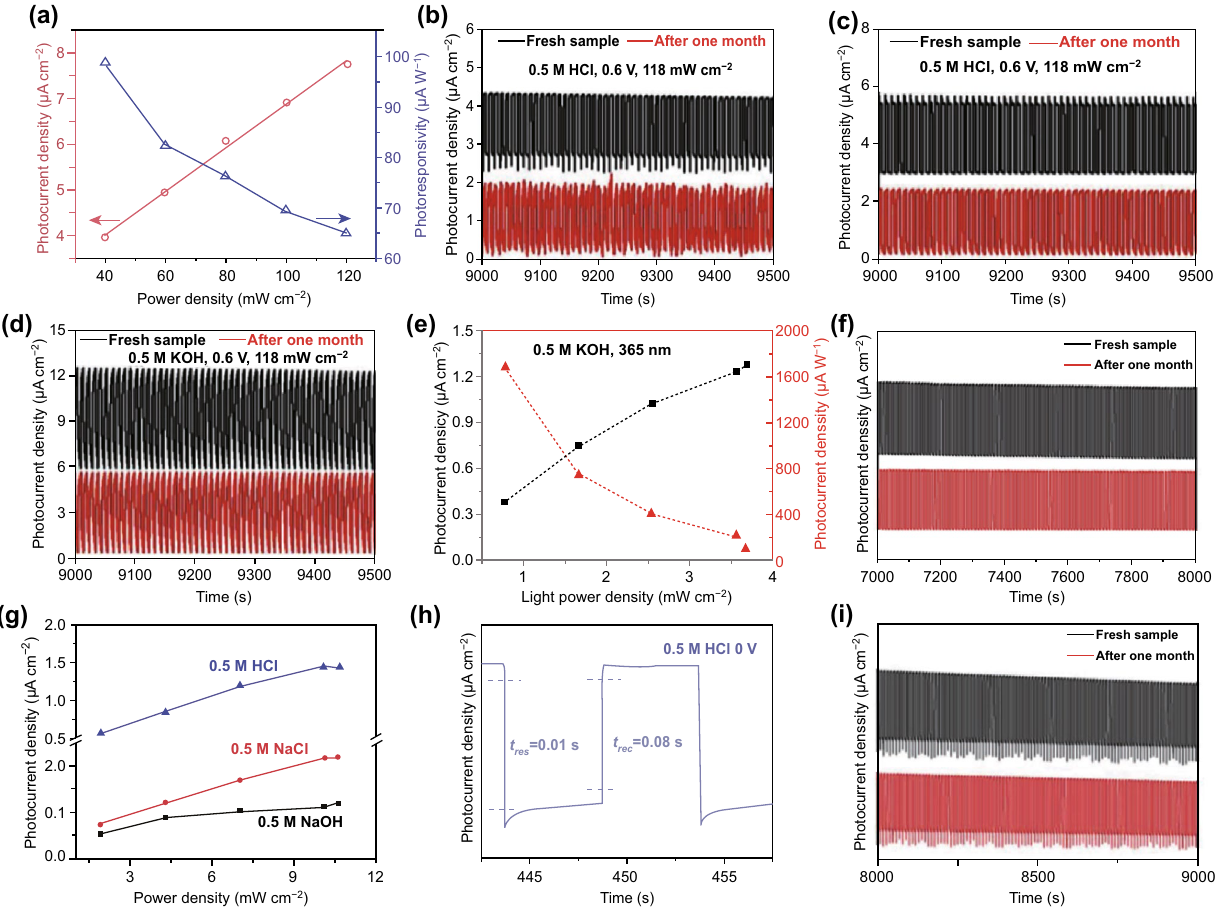
Fig. 11 a Photocurrent density and photoresponsivity of Te 0.37 @Se 0.63 as a function of power density in 0.5 M KOH. b – d Stability measure‑ ments of the photocurrent density in different solutions, comparing on/off cycles for a fresh device to a device after 1 month of continuous exposure. Adapted with permission from [138]. Copyright 2019, WILEY–VCH. e Photocurrent density and photoresponsivity of the device as a function of incident laser power with a wavelength of 365 nm. f Stability measurement of the Te@Bi heterojunction‑based photodetector. Adapted with permission from [139]. Copyright 2019. WILEY–VCH. g Photocurrent density as a function of the incident laser power with a wavelength of 475 nm in three different electrolytes. h Response and recovery time of the Te/Bi 2 Se 3 @Se self‑powered device in 0.5 M HCl electrolyte. i Stability measurement of the Te/Bi 2 Se 3 @Se self‑powered device in 0.5 M HCl electrolyte. Adapted with permission from [140]. Copyright 2019,